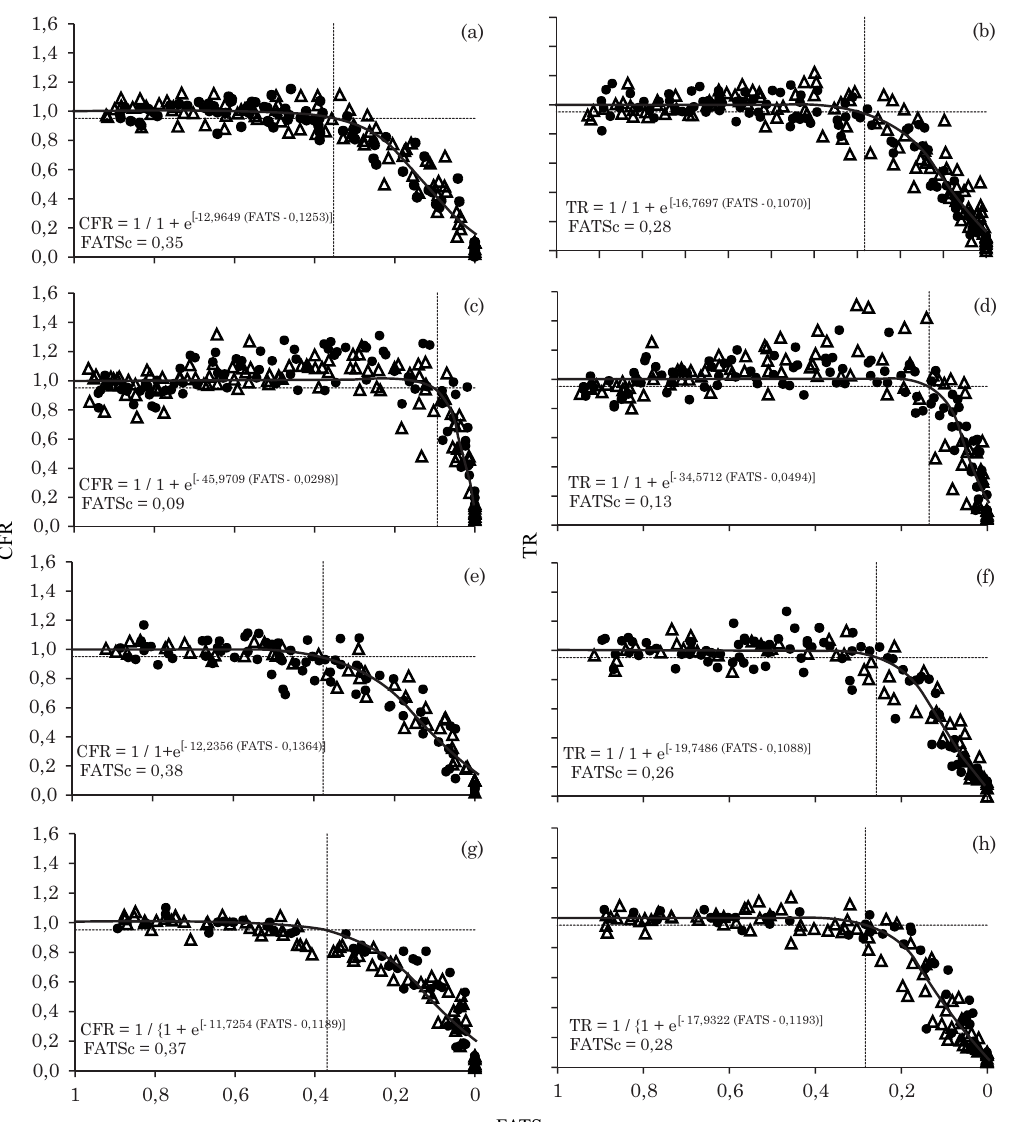
Figura 2. Crescimento foliar relativo (CFR) e transpiração relativa (TR) em função da fração da água transpirável do solo (FATS) em plantas de mandioca, cultivar Fepagro RS 13, em períodos sem irrigação: RH2 no período 1 (a, b) e no período 2 (c, d); RH3 no período 1 (e, f); e RH4 no período 2 (g, h), em experimentos iniciados em 29/09/2011 (círculo) e em 24/11/2011